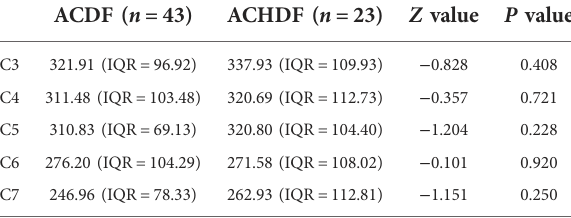
TABLE 2 The comparison of HU in C3 – C7 of the two groups of ACDF and ACHDF.